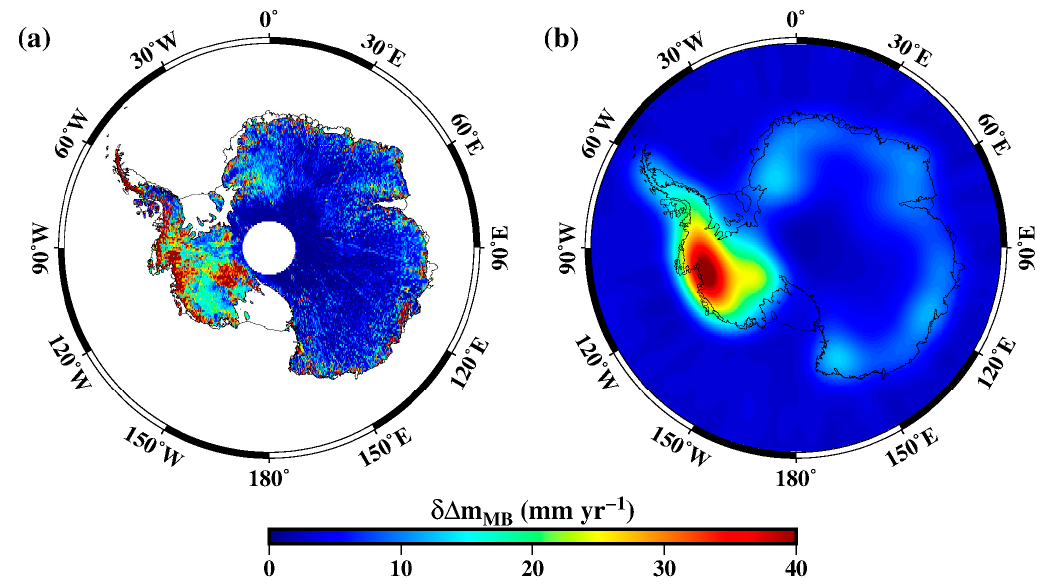
Figure 6. The uncertainties for ( a ) ice sheet and ( b ) GIA-related mass change derived from joint inversion estimation, in units of equivalent water height.